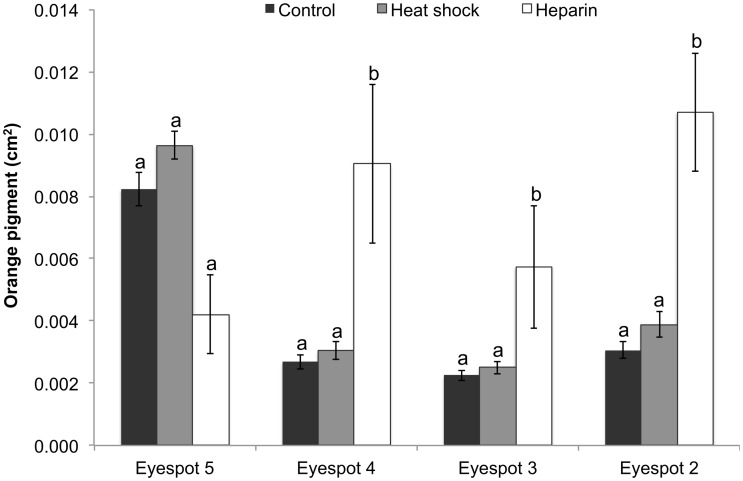
Area of orange pigment across all four eyespots in the different treatments.Data represent the area in cm2 with error bars representing 1 SE from the mean. The 2-way ANCOVA was performed on log10-transformed data. Results shown in Table 1. Different letters above the bars indicate significant differences within each individual eyespot.